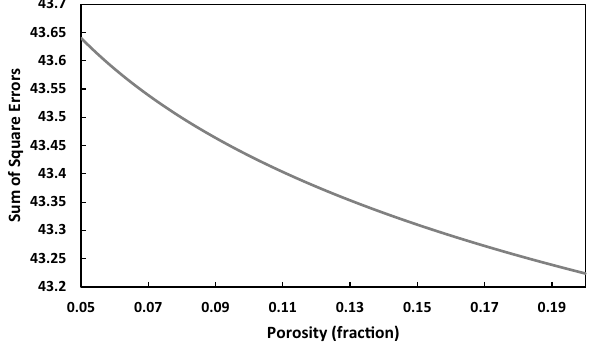
Fig. 7 The impact of porosity on the error between pseudo-pressure before and after correction